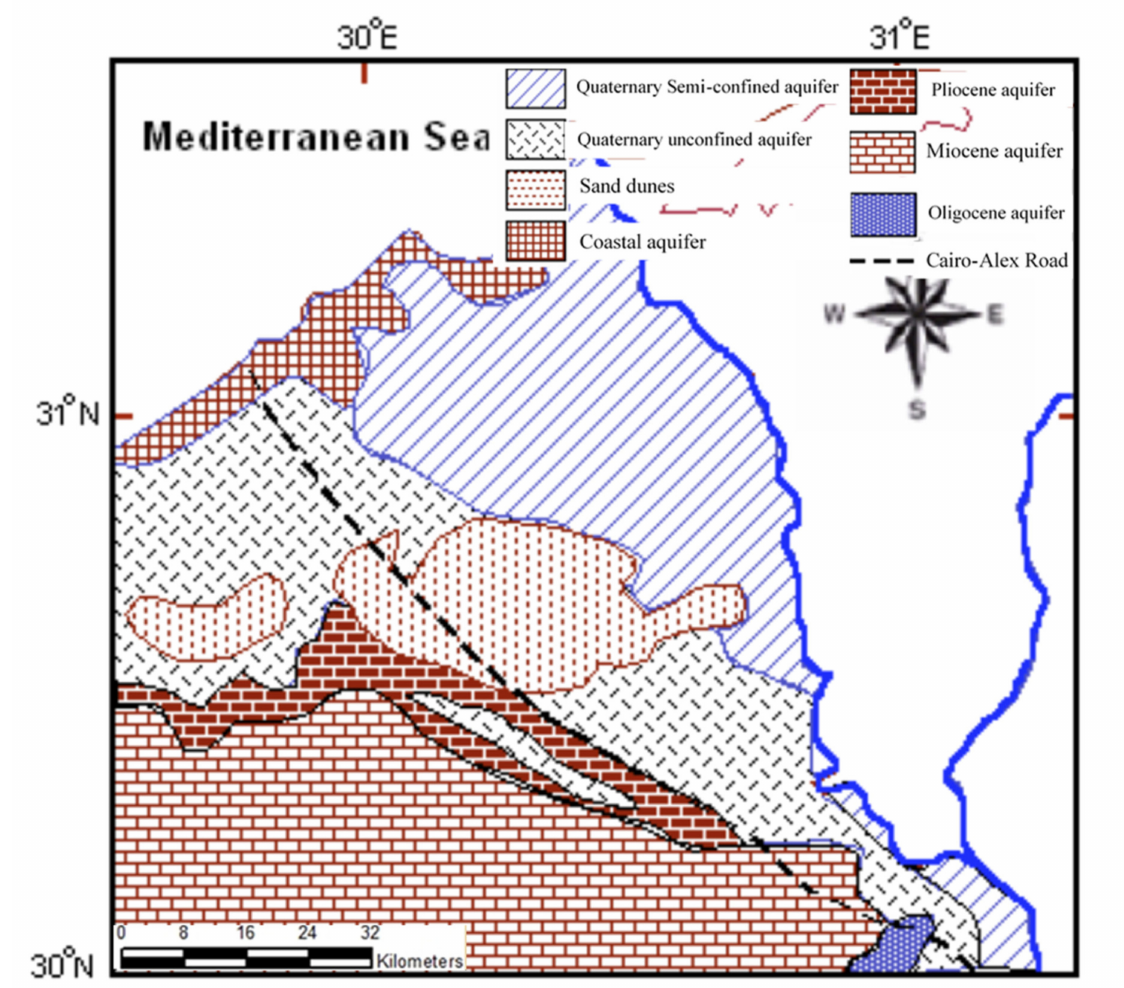
Figure 3. Groundwater aquifers in the western Nile Delta (after RIGWA,